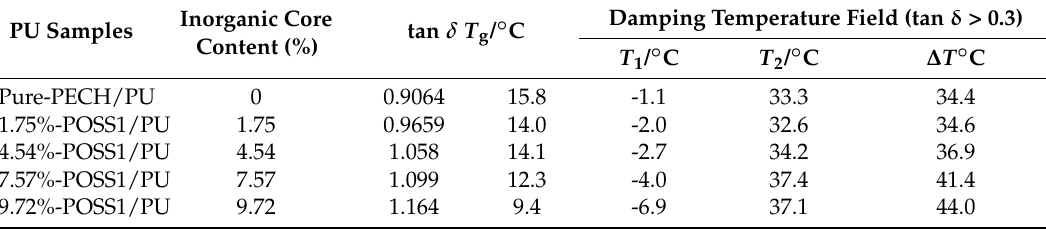
Figure 4. This loss factor (tan δ ) curves vs temperature for: ( a ) The neat PU matrix and PUs with different POSS contents (POSS–PECH with same molecular weight), ( b ) PUs with different POSS contents (POSS–PECH with different molecular weights), ( c ) PUs with different isocyanate indexes (R) and ( d ) PUs response to different strain frequencies. Table 5. Summary of DMA data of PUs with different POSS contents (POSS–PECH with same molecular weight).